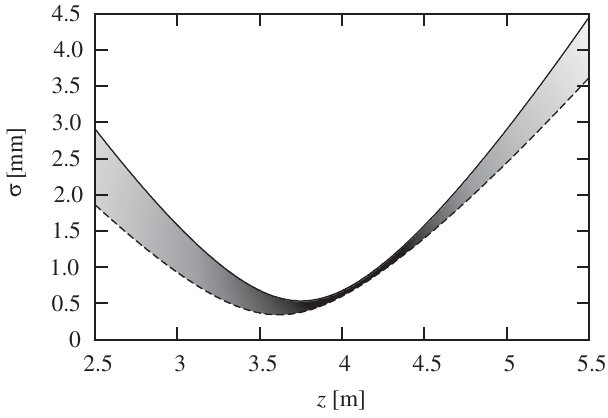
FIG. 6. Slice size development of the high perveance slice (solid line) and the low perveance slice (broken line) after a focusing kick from a numerical integration of the envelope equation. The development within the first 2 m is shown in Fig. 3; the focusing kick is applied at z ¼ 2 m. The envelopes of slices with intermediate perveance will fall into the gray shaded